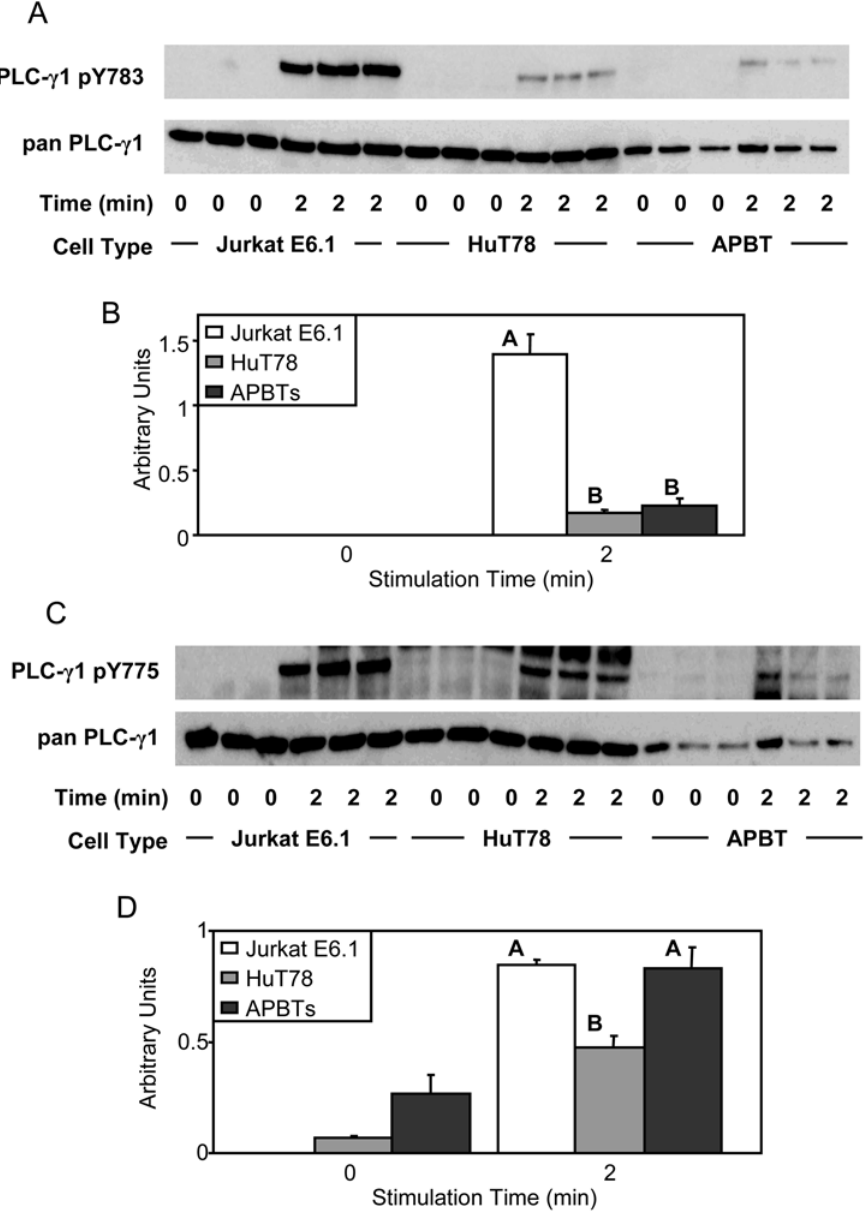
Figure 5. T cell lines have differences in PLC c 1 phosphorylation. (A) Three samples of Jurkat E6.1 T cells, HuT78 T cells, and APBTs were stimulated and the cellular proteins were separated by SDS-PAGE. The site-specific phosphorylation and expression of PLC c 1 was assessed by immunoblotting using PLC c 1 pY783 (top) and pan-PLC c 1 (bottom) antibodies. (B) The immunoblots were analyzed by densitometry and the ratio of the intensity of the phosphospecific PLC- c 1 band to the pan-PLC- c 1 band for each cell line was averaged. Letters represents significant differences of p , 0.0005. (C) Three samples of Jurkat E6.1 T cells, HuT78 T cells, and APBTs were stimulated and the cellular proteins were separated by SDS-PAGE. The site-specific phosphorylation and expression of PLC c 1 was assessed by immunoblotting using PLC c 1 pY775 (top) and pan-PLC c 1